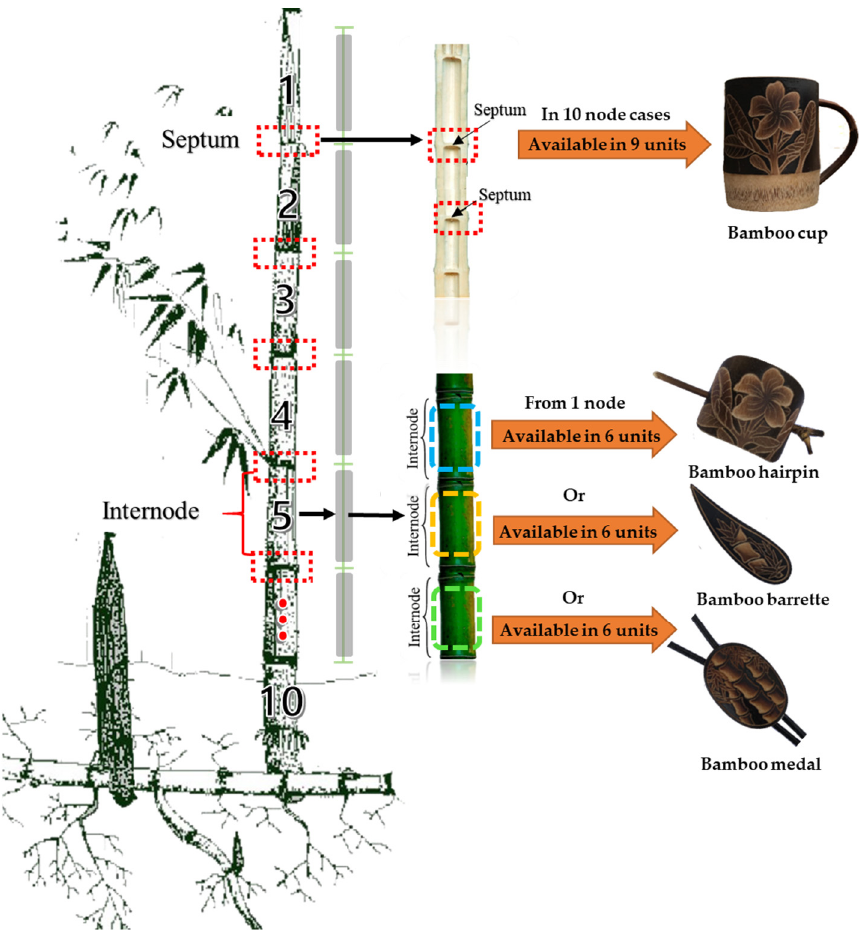
Figure 6. Bamboo harvesting, collection, and management steps: ( a ) cutting bamboo culm by node, ( b ) treating bamboo outer skin with gas torch, and ( c ) drying the treated bamboo material using a kitchen stove.